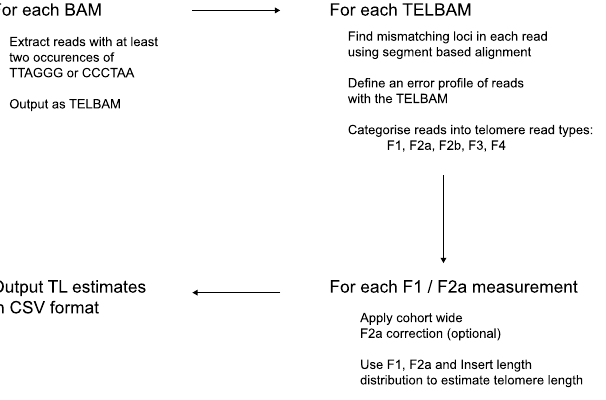
Figure 6. An overview of the Telomerecat length estimation